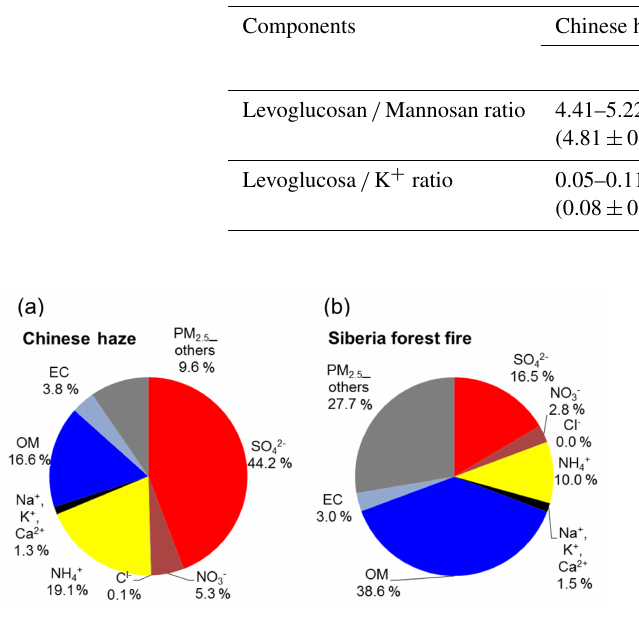
Figure 10. Average relative contributions to PM 2 . 5 mass during the (a) Chinese haze and (b) Siberian forest fire